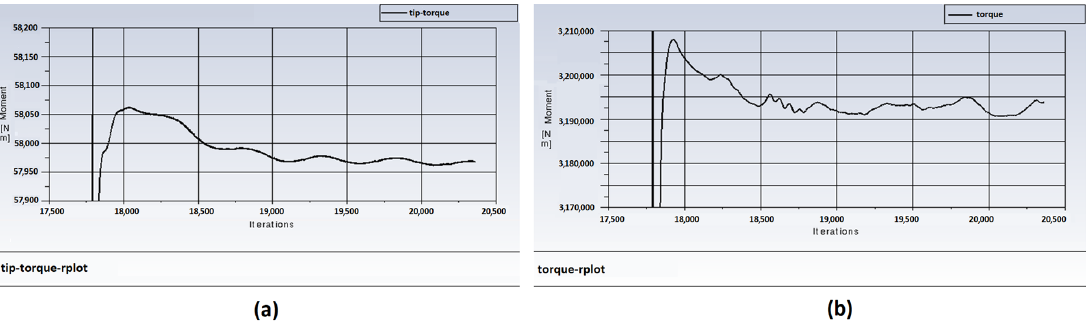
Figure 9. Torque value graphs against CFD iterations. ( a ) Torque generated on the tip of the blade, ( b ) torque generated on the whole blade.